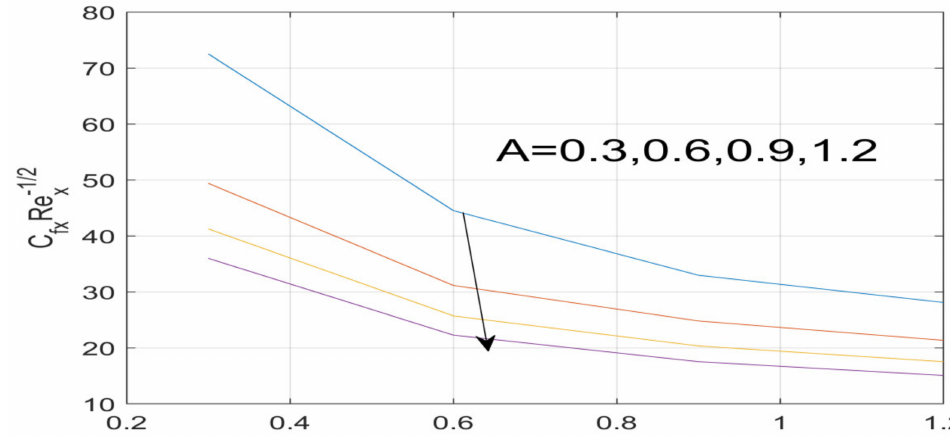
Figure 21. Impact of N on fˆ” (0).